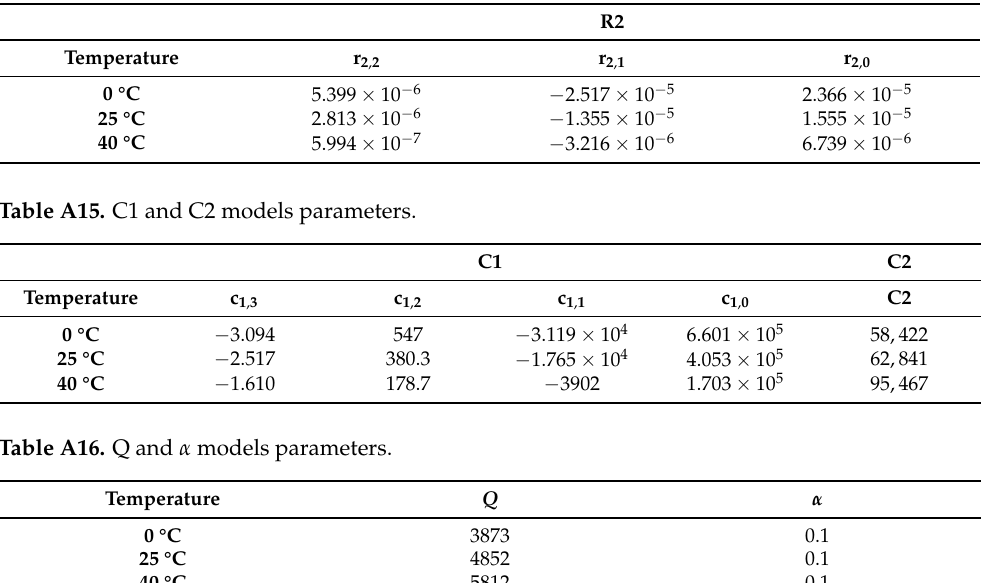
Table A14. R2 models parameters.